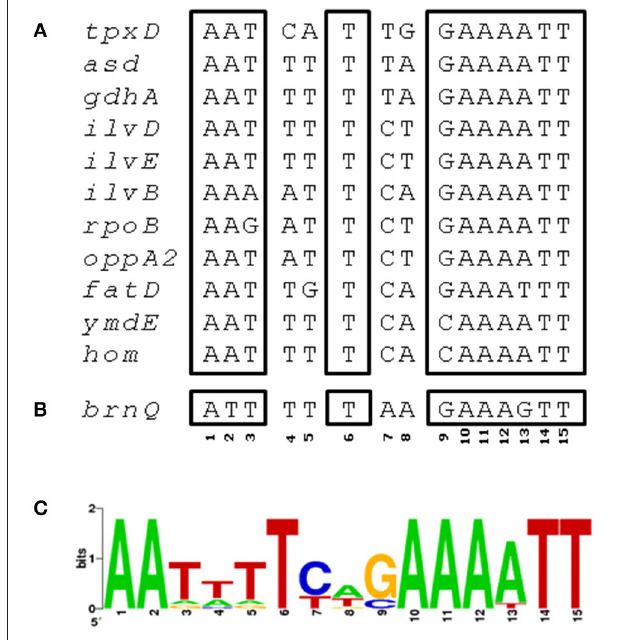
FIGURE 3 | CodY binding site in tpxD promoter region. (A) ClustalW was used to align the 83 bp upstream to tpxD -coding sequence with several pneumococcal genes known to be regulated by CodY. A region of 15 bp, between − 26 and − 40, upstream to tpxD -transcription start site, with high homology to CodY binding motif in L. lactis , is presented. (B) Putative CodY binding site in the upstream region of brnQ. (C) Position specific weight matrix for S. pneumoniae CodY binding motif deduced from CodY-regulated, established and putative genes ( Figure 3A ), identified by bioinformatic analysis of the microarray data, using RegPrecise database. The matrix (created at http://weblogo.berkeley.edu/) shows the relative frequency of occurrence of each of the 4 nucleotides (A, T, C, G) at each of the 15 positions of the